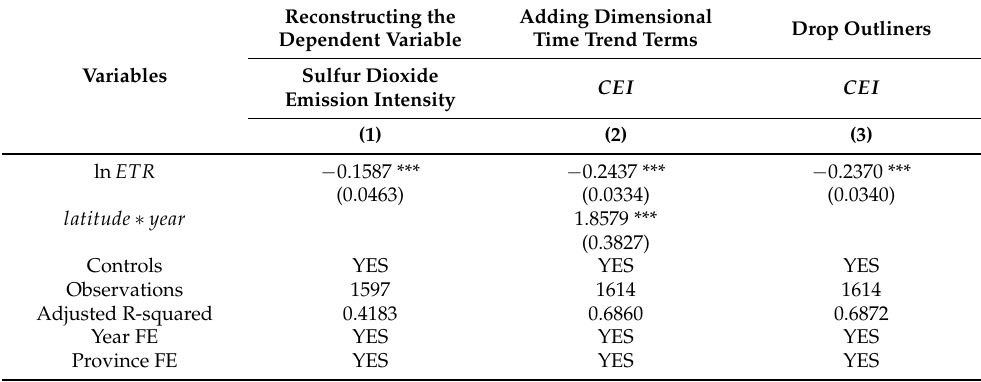
Table 7. Robustness